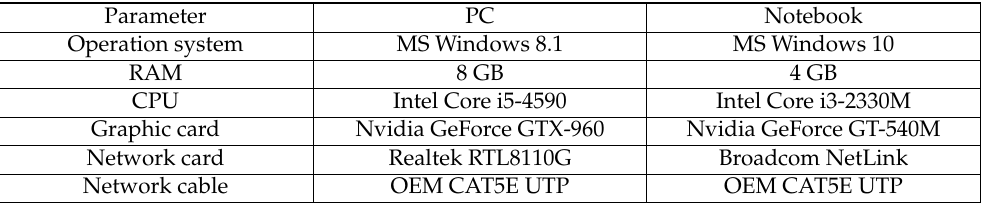
Table 3. Servers